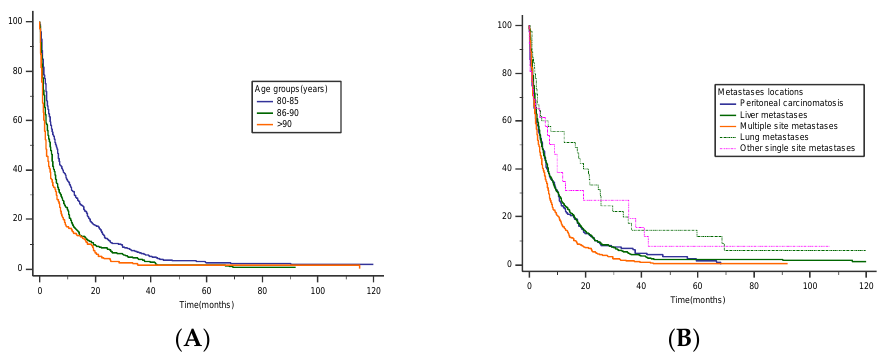
Figure 1. ( A ) Survival rates stratified by age groups (80 – 85 years (median 5.90, 95% CI 4.71 to 6.67), 86 – 90 years (median 3.71, 95% CI 3.00 to 4.45), >90 years (median 2.22, 95% CI 1.77 to 3.12), Log-rank p < 0.0001). ( B ) Survival rates stratified by metastases location (Peritoneal carcinomatosis (median 4.66, 95% CI 3.29 to 5.90), Liver metastases (median 4.54, 95% CI 3.83 to 5.36), Multiple site metastases (median 3.43, 95% CI 2.77 to 4.22), Lung metastases (median 16.29, 95% CI 3.90 to 21.35), Other single site metastases (median 8.96, 95% CI 2.35 to 12.93), Log-rank p < 0.0001). Univariate analysis revealed improved OS for patients with low comorbidity burden (CCS ≤ 1) compared to those with higher comorbidities scores ( p = 0.03) (mean OS of 9.4 (0 – 123) months versus 7.9 (0 – 115) months, respectively). Age was not significantly corre- lated with the comorbidity burden ( p = 0.46). Patients with lung metastases (HR 0.56 95% CI 0.40, 0.77 p < 0.001) had better prog- nosis than those with liver metastases. Conversely, patients with multi-organ metastases (HR 1.32 95% CI 0.15, 0.51 p < 0.001) had poorer survival (mean OS of 6.5 (0 – 43) months) than those with peritoneal metastases (mean OS of 9.4 (0 – 41) months) (Figure 1B) (Table 2). Table 2. Survival and Prognostic Factors.